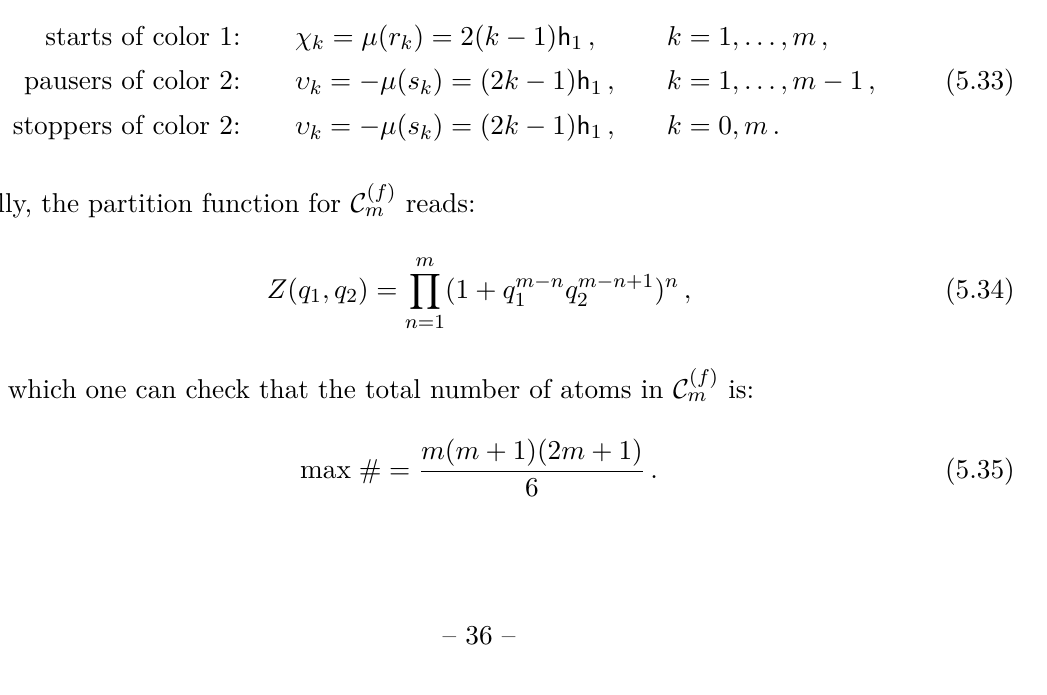
Figure 8 . (a) The crystal for the finite chamber C ( f ) m of the resolved conifold, with m = 4 . (b) The locations of the starters at x with k = 1 , 2 , . . . , m , the pausers at y k the stoppers at y and y 0 m